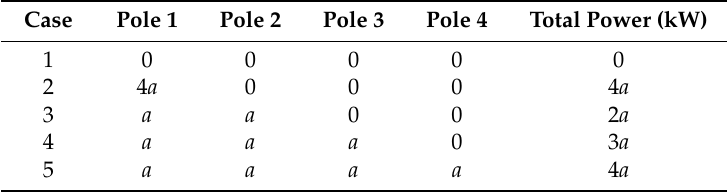
Table 2. The total power of 4 hybrid poles in 5 cases.